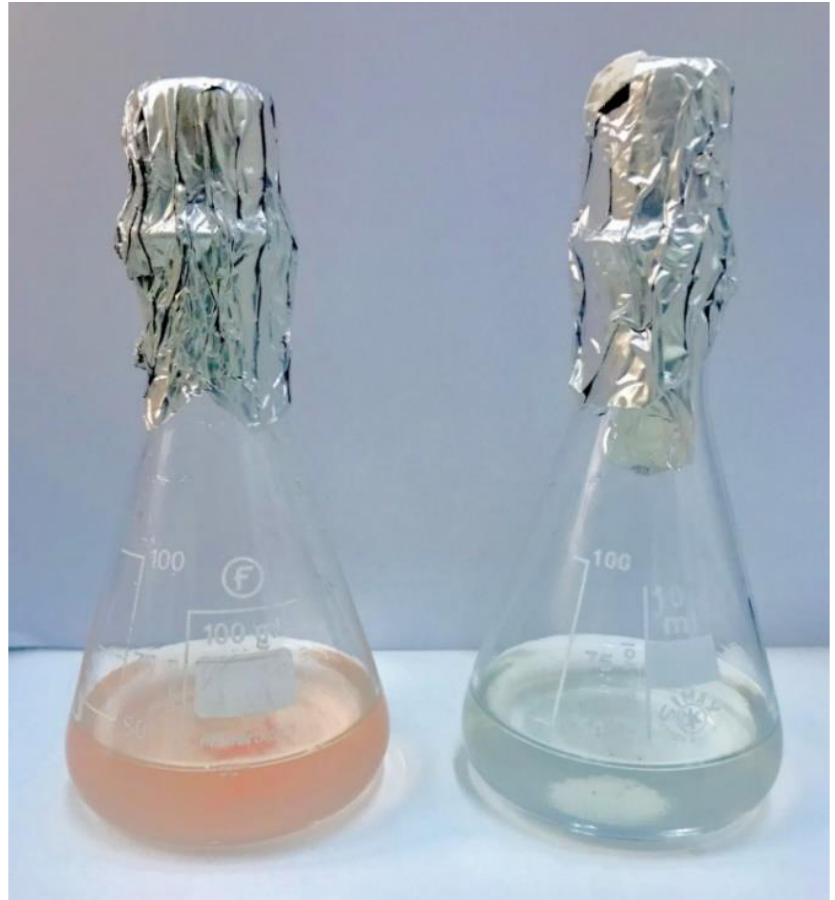
Figure 1. Liquid culture of G. phototrophica showing growth in the medium containing 50 mg CaCl 2 − 1 ( left flask) and no growth in medium without added CaCl L −1 (left flask) and no growth in medium without added CaCl 2 (right flask). L